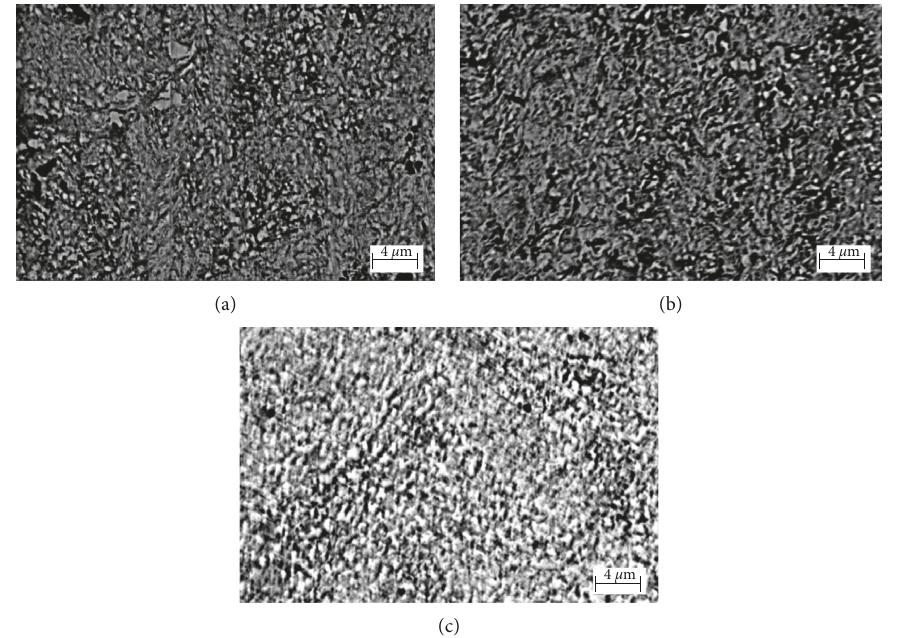
Figure 2: The structure of 40Kh steel at the optimum parameters after V SO at depths of ( a ) 100 and (b) 500 μ m and (c) the initial lattice structure.